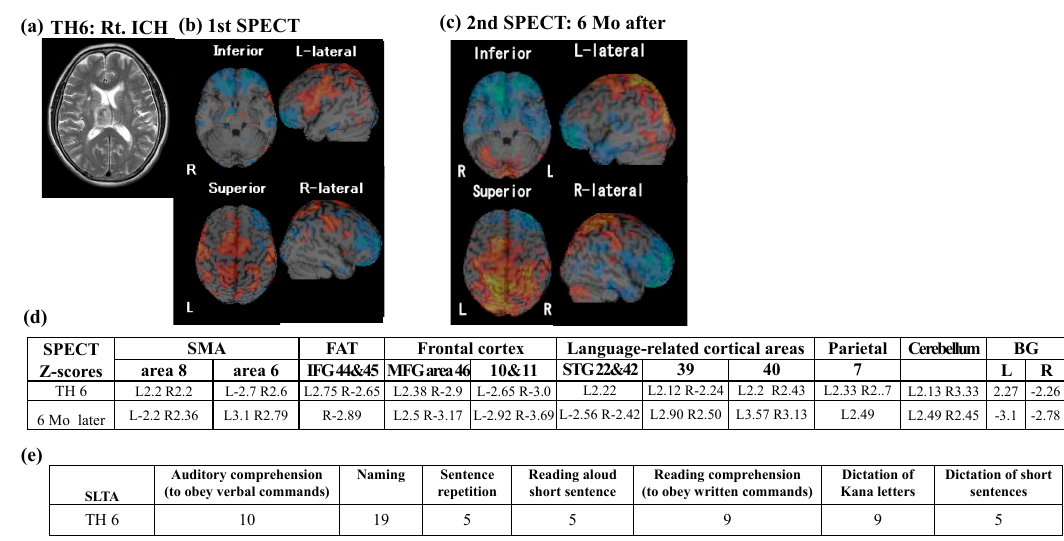
Figure 3. Repeated SPECT results from TH6. ( a ) Axial view of T 2 -weighted MRI. ( b ) First SPECT Z-map. L: left; R: right. ( c ) Second SPECT Z-map 6 months later. ( d ) Details of regional SPECT Z scores. Note that hyper-perfusion in left inferior frontal gyrus (IFG) returned to a normal level 6 months later. ( e ) SLTA results at first SPECT. Mo: month.